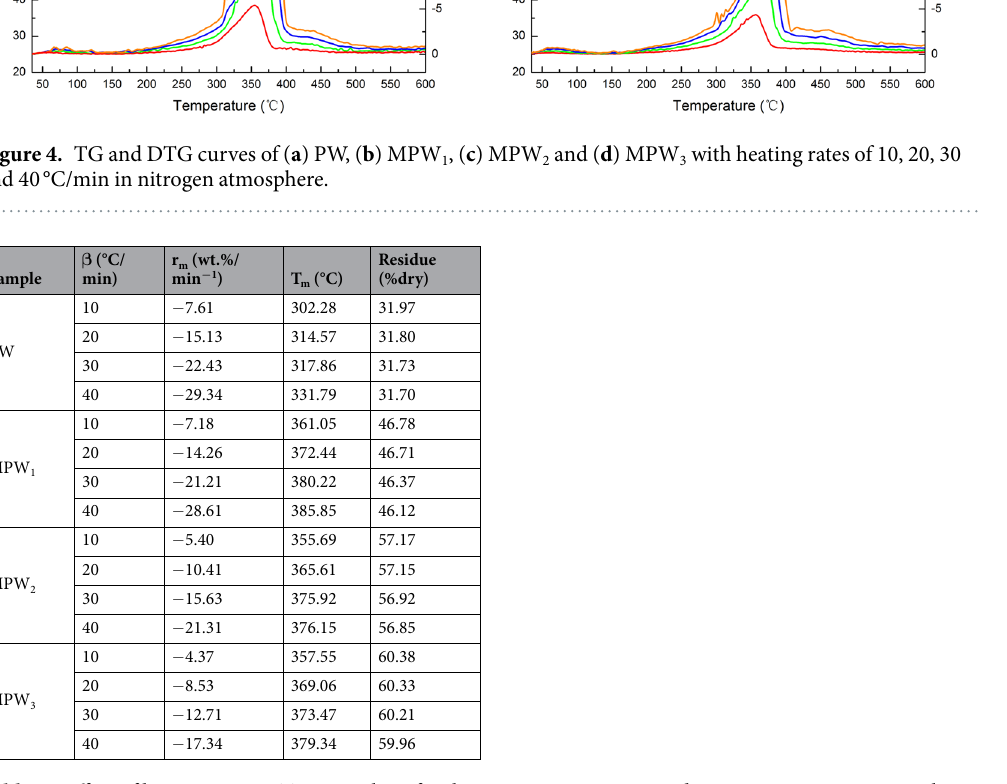
Table 1. Effect of heating rate on TGA pyrolysis for the PW, MPW 1 , MPW 2 and MPW 3 in nitrogen